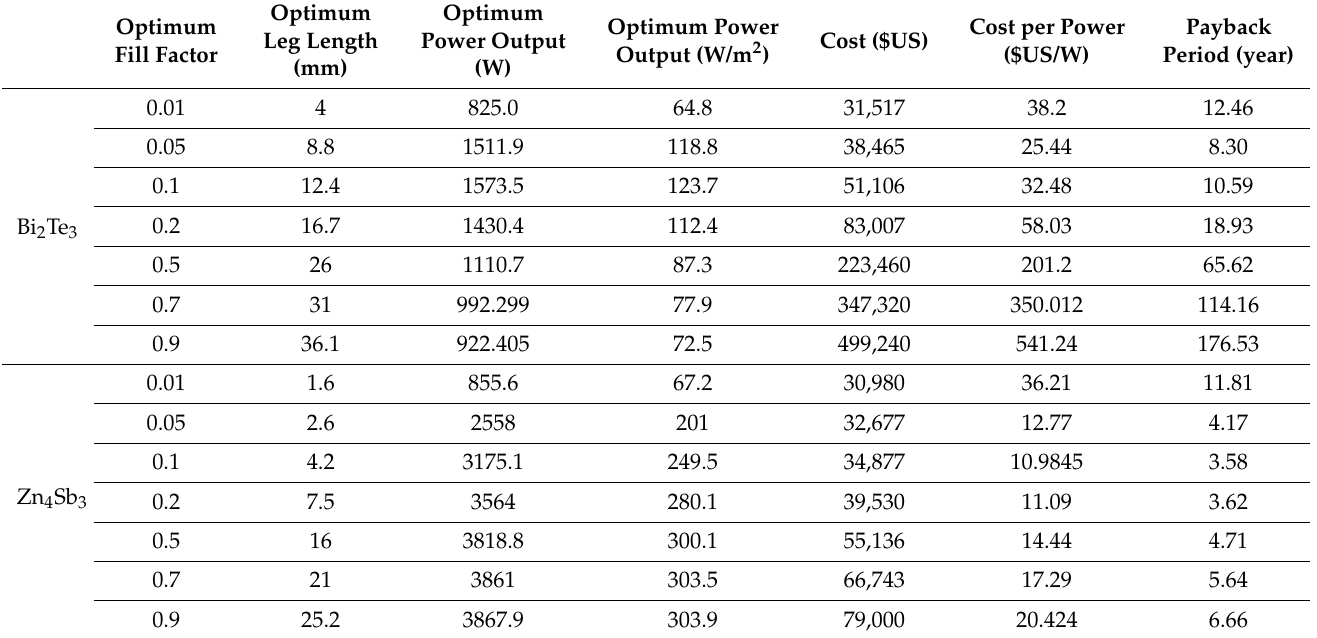
Table 1. Optimum design characteristics for the TEG systems fabricated by Bi 2 Te 3 and Zn 4 Sb 3 -based thermoelectric compounds